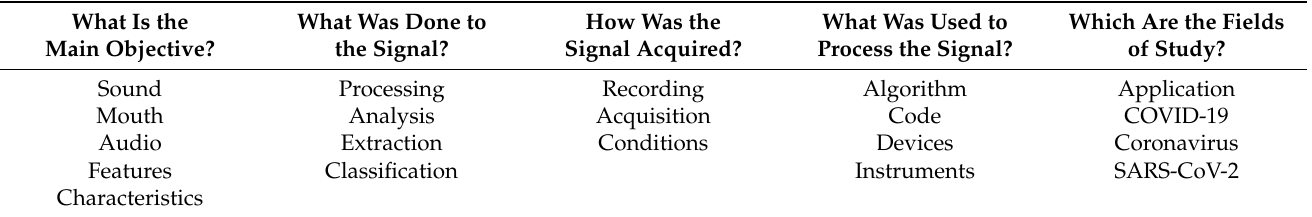
Table 1. List of words used for this research. These keywords were used in the different databases to limit the research of material to only the topics of interest.